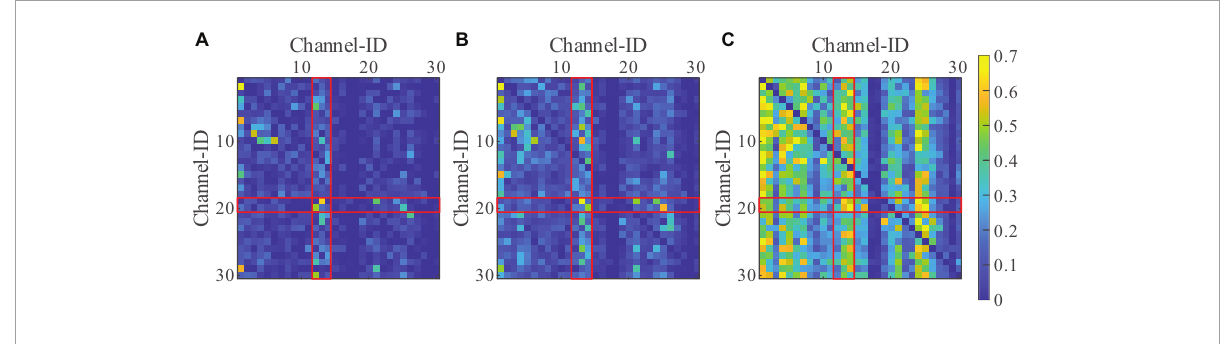
FIGURE8 The normalized slight-facial expression (sFEs)-averaged generalized orthogonalized partial directed coherence (gOPDC) over normal threshold of (A) low frequency, (B) medium frequency, and (C) high frequency, where the value between the same channels were assigned as “NaN,” and the Channel ID.1 to ID.30 were listed as: Fp1, Fp2, Fz, F3, F4, F7, F8, FC1, FC2, FC5, FC6, Cz, C3, C4, T3, T4, CP1, CP2, CP5, CP6, Pz, P3, P4, T5, T6, PO3, PO4, Oz, O1, and O2. The block in i th row and j th column represents the gOPDC from Channel ID. j to Channel ID. i